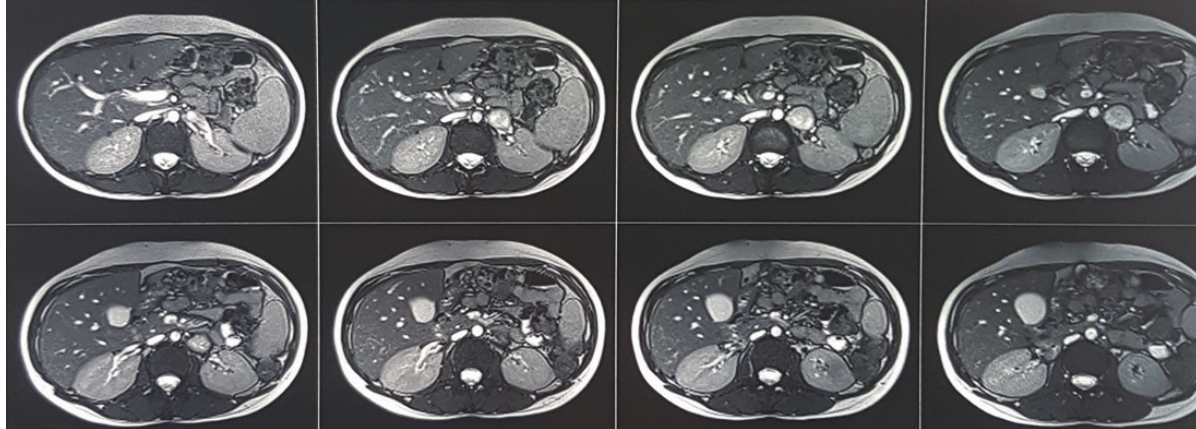
figure 1 - Magnetic Resonance Imaging (MRI) of abdomen showed a round soft tissue mass measuring 3x3.5cm medial to left renal hilum, compatible with extra adrenal pheochromocytoma